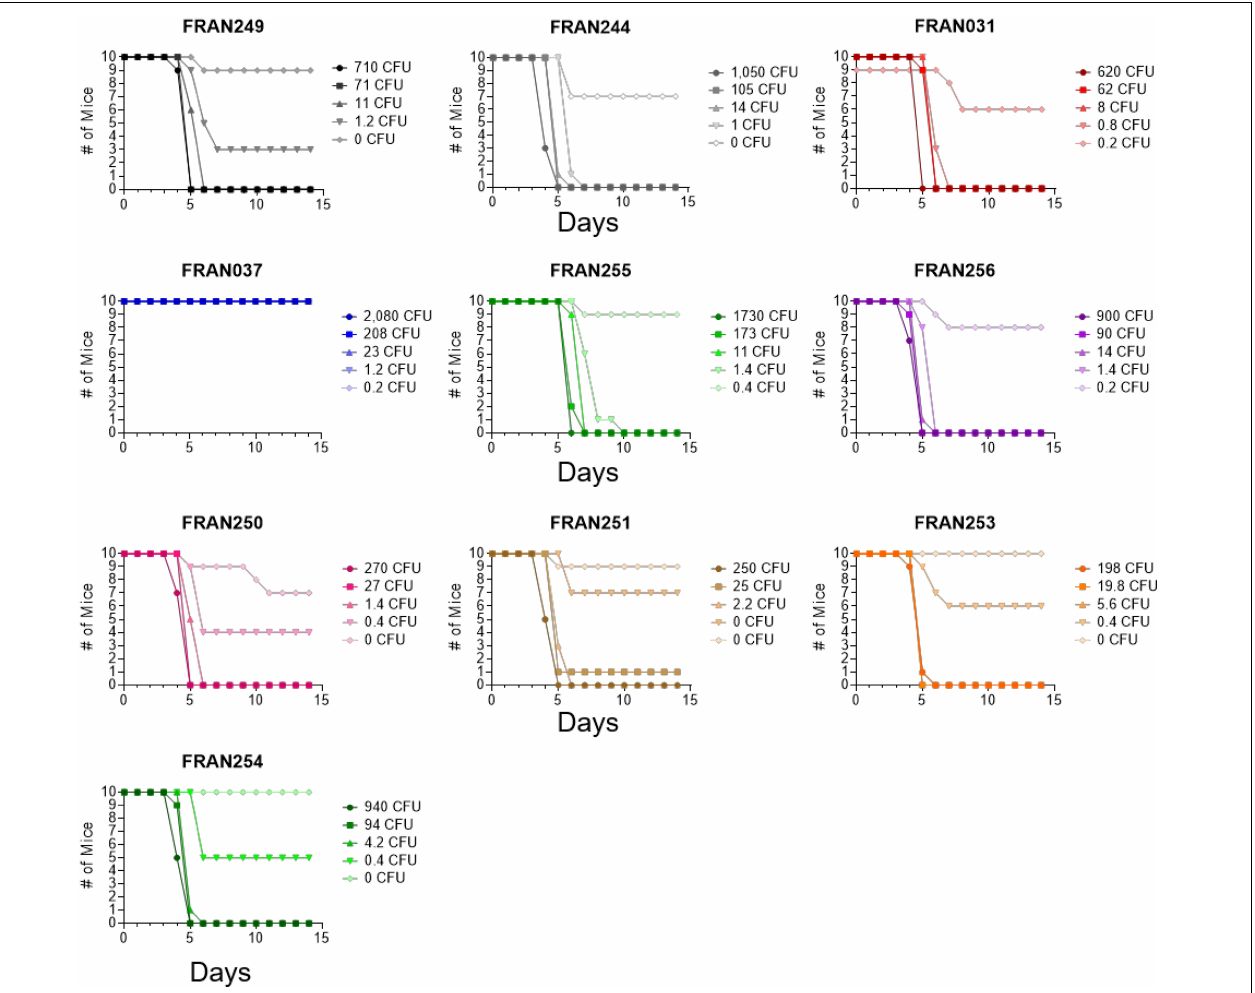
FIGURE 7 | Survival data of mice challenged intranasally with F. tularensis . Groups of BALB/c mice ( n = 10) were challenged and survival monitored following infection by intranasal instillation. Each group was challenged with the designated strain from the diversity panel. The calculated LD 50 values from these experiments are included in Table 4